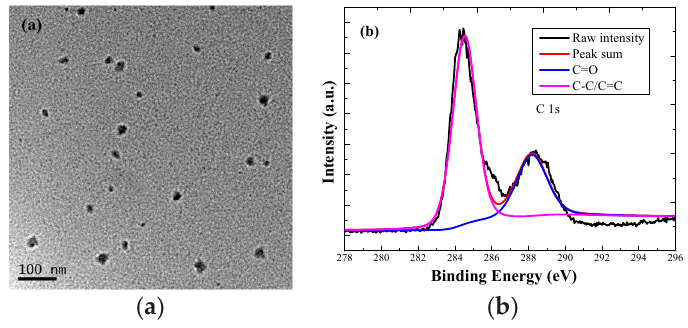
Figure 2. ( a ) TEM image of the CQDs. ( b ) XPS C 1s spectrum of the CQDs.